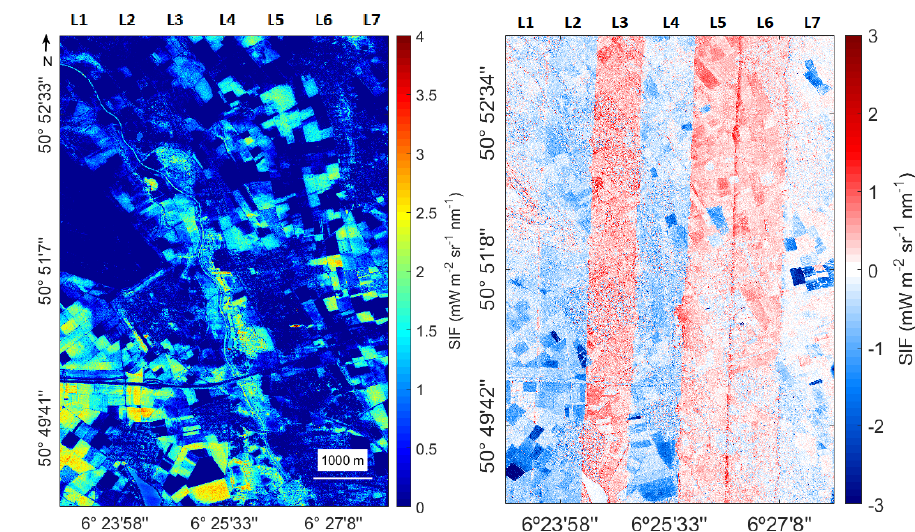
Figure 11. Subset of the emulated SIF mosaic at 760 nm using all investigated flight lines ( left ). Absolute error map calculated for the emulated and the SFM SIF mosaic at 760 nm ( right